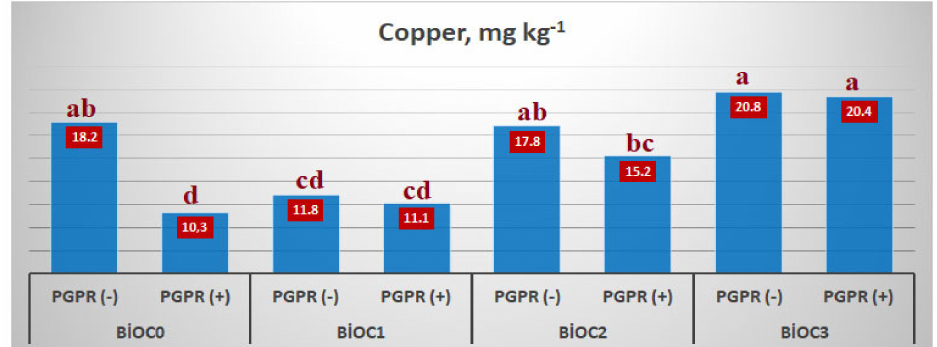
Figure 6. Effect of BxP interaction on copper content of einkorn wheat: PGPR(+): Inoculation; PGPR(-): Non-inoculation; BioC 0 : 0% biochar; BioC 1 : 2.5% biochar; BioC 2 : 5% biochar; BioC 3 : 10%